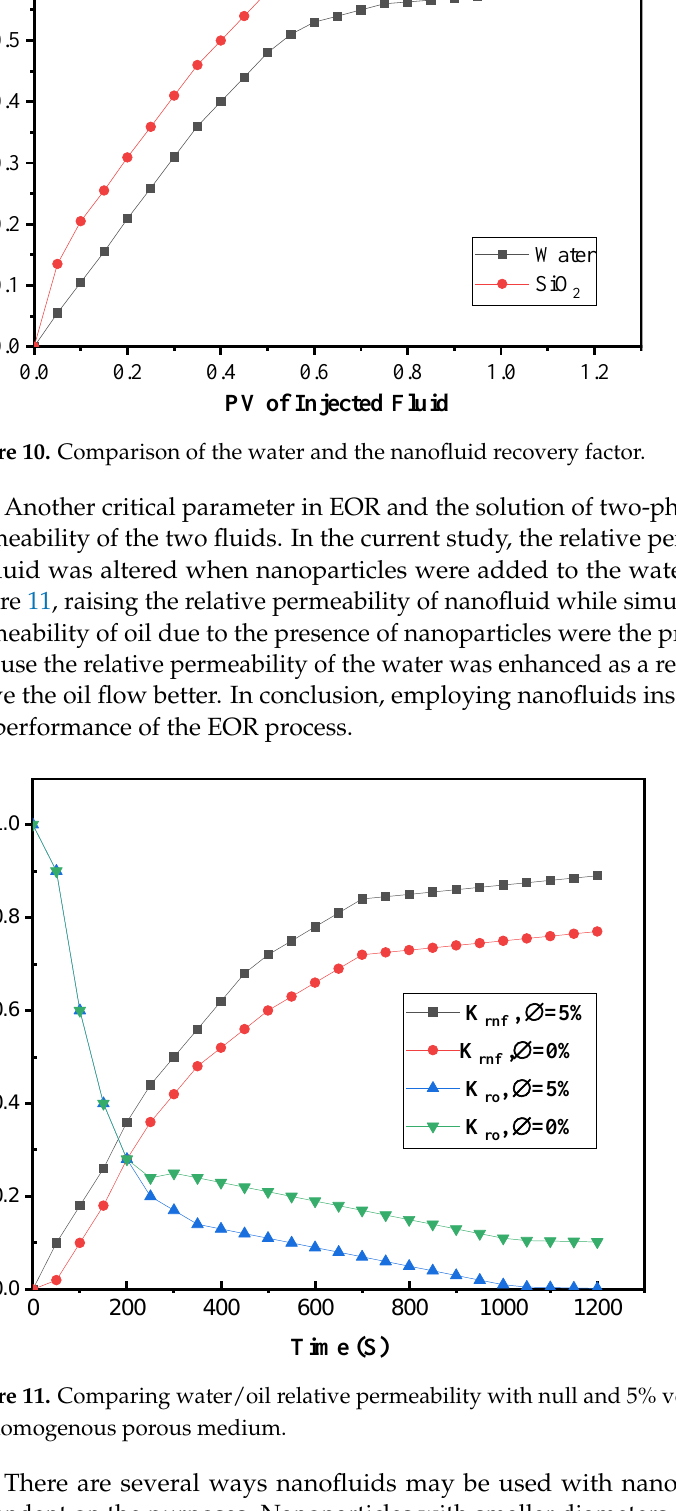
Figure 9. ( a ) Pressure distribution inside the porous medium at 200 s, ( b ) pressure distribution inside the porous medium at 400 s, and ( c ) pressure distribution inside the porous medium at 600 s.